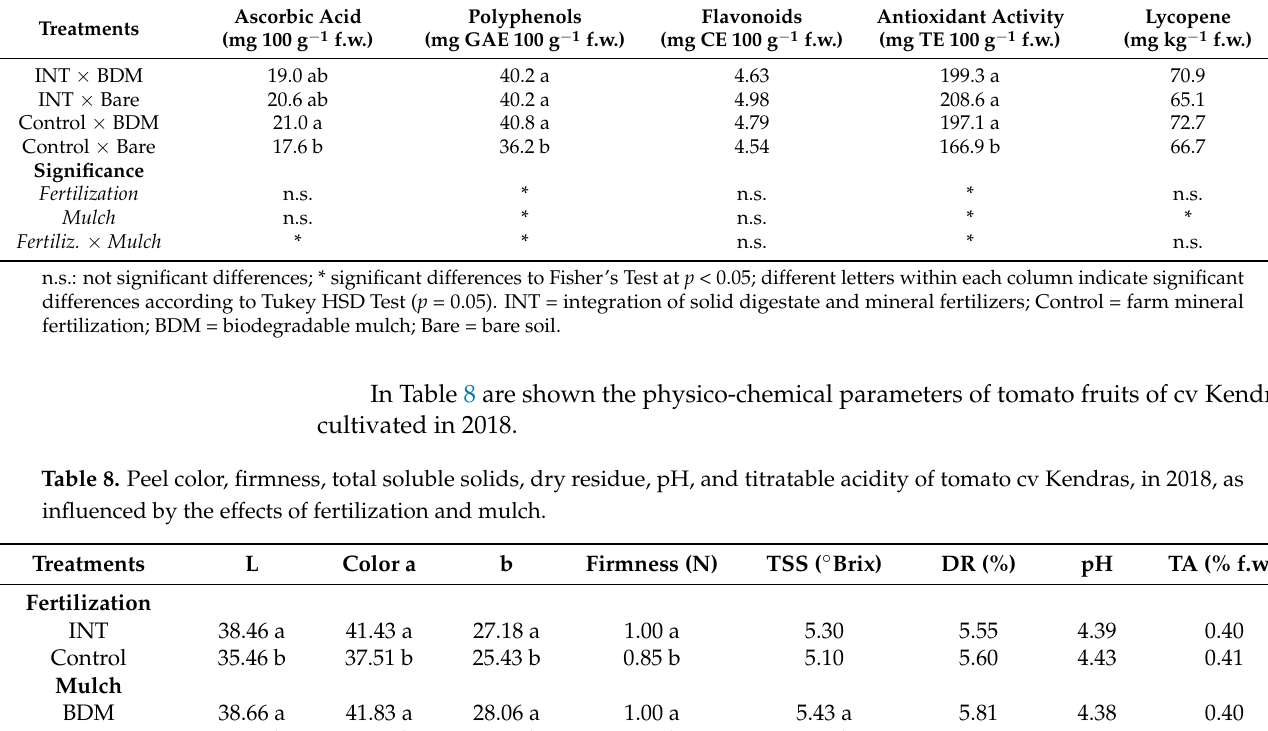
Figure 5. Effects of the interaction Fertilization * Mulching on the firmness ( A ) and titratable acidity ( B ) of fruits of Heinz 5508 in 2017. Legend: vertical bars represent standard error of mean (N = 10) per each treatment. Letters on the top of columns indicate means are significantly different to Tukey HSD Test ( p = 0.01). Control × Bare: standard farm fertilization × Bare soil; Control × BDM: standard farm fertilization × Biodegradable mulch; INT × Bare: solid digestate integrated with mineral fertilizers × Bare soil; INT × BDM: solid digestate integrated with mineral fertilizers × Biodegradable mulch. Table 7. Antioxidant compounds and antioxidant activity in tomato cv Heinz 5588, as influenced by the interaction of Fertilization and mulch in 2017.